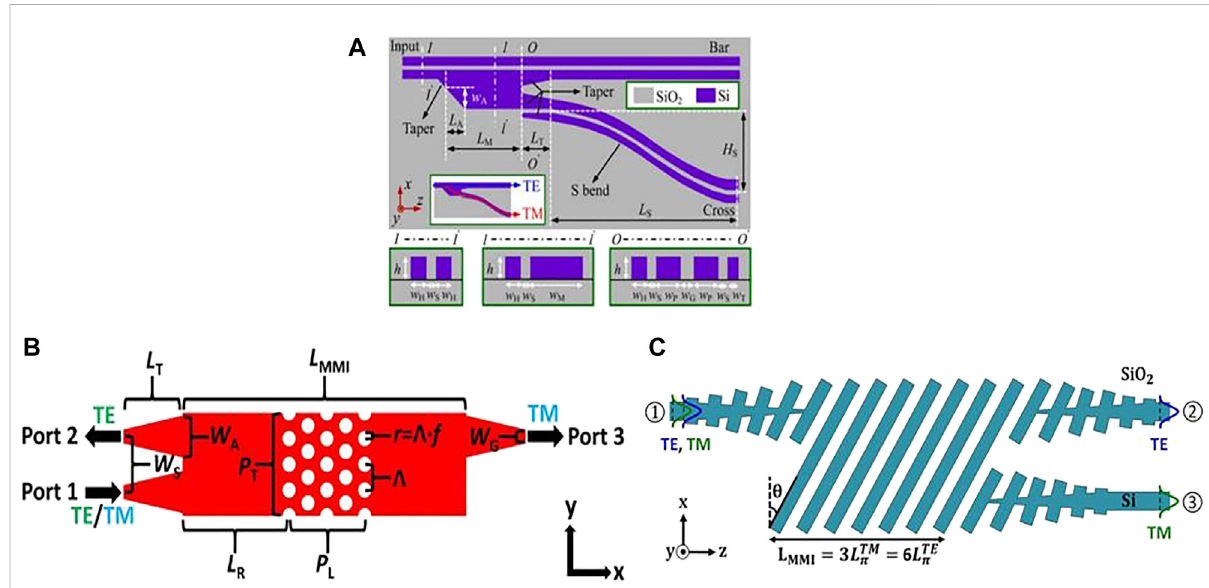
FIGURE 2 MMIcouplingstructureforpolarizationbeamsplitting. (A) MMIpolarizationbeamsplitterbasedonslotwaveguide[52]. (B) Thephotoniccrystal structure is etched in the multimode region, and the two polarizations are separated from each other in the opposite direction [57]. (C) The inclined grating structure is used to replace the traditional MMI to realize the independent selection of two orthogonal polarization [59]. Figure reproduced with permission from: (A) , © 2014, Institute of Electrical and Electronics Engineers (IEEE); (B) , © 2019, Institute of Electrical and Electronics Engineers (IEEE); (C) , © 2019, Institute of Electrical and Electronics Engineers